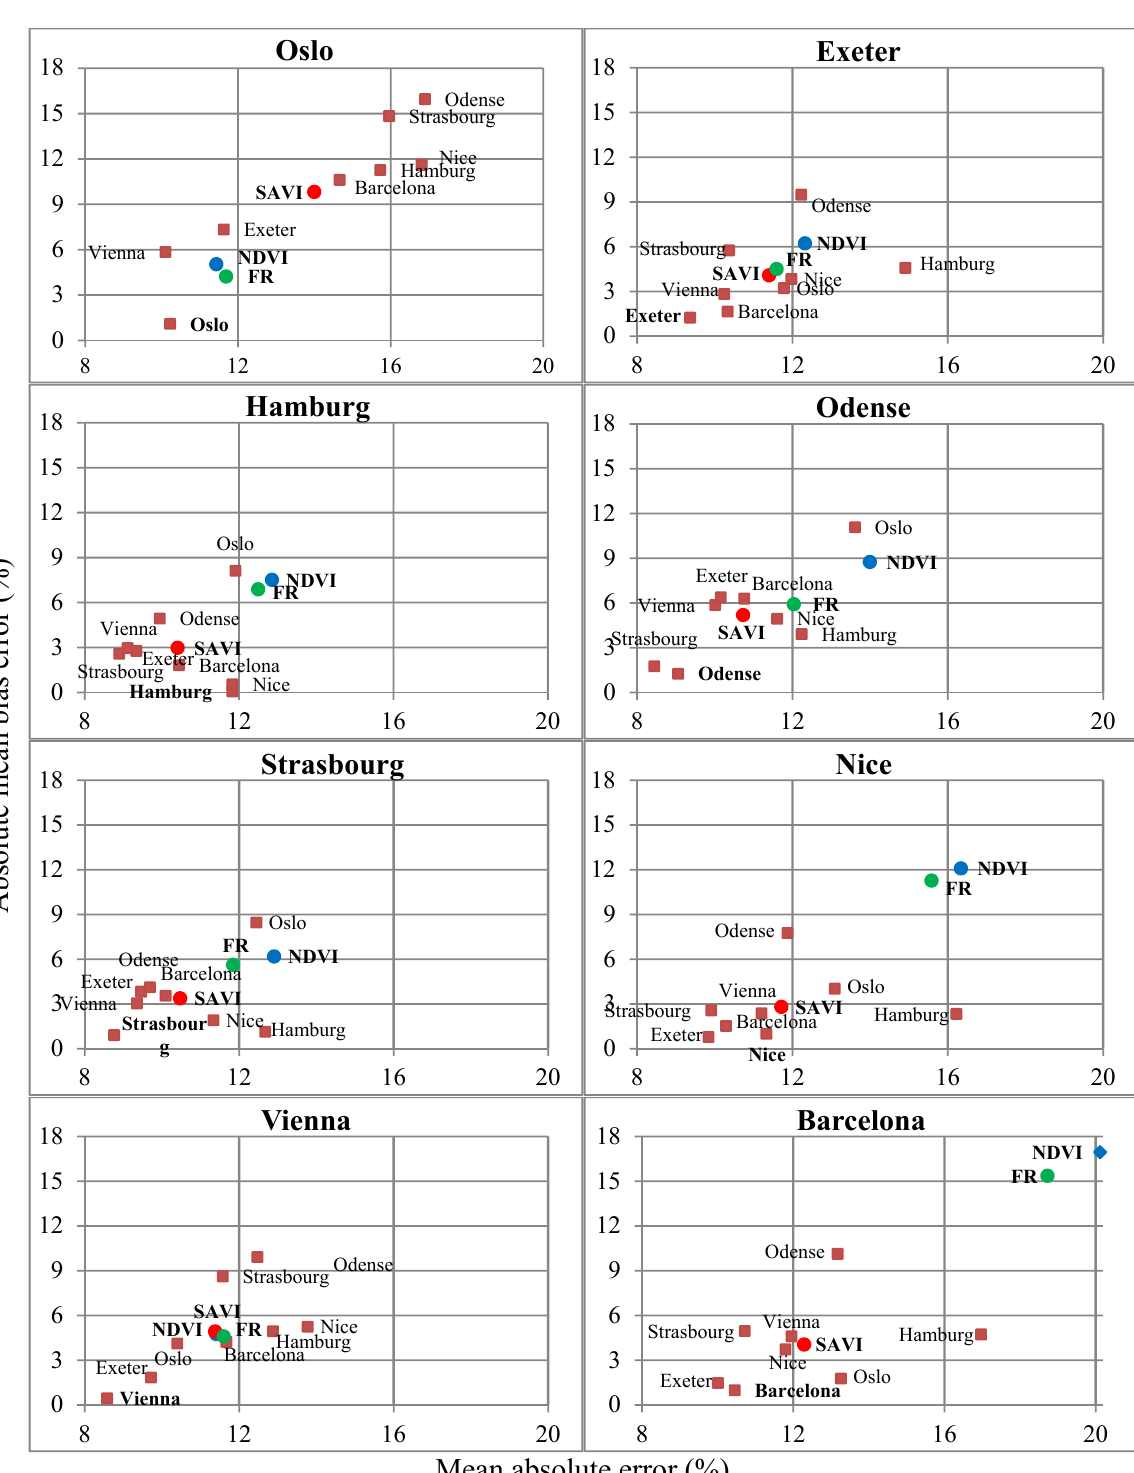
Figure 8. MAEs and absolute MBEs for all possible combinations of urban areas for the second order polynomial regression models based on SAVI. Chart title = the city where the model were developed. NDVI, SAVI and FR are the averages of the different indices for the second order polynomial regression